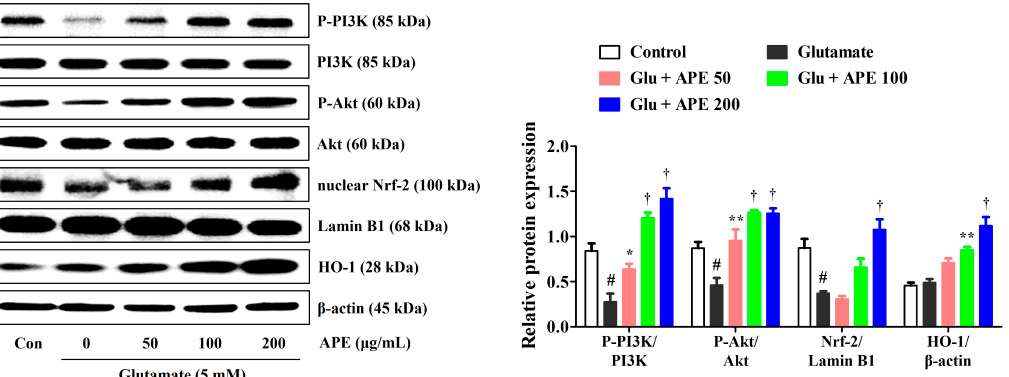
Figure 6. Effects of Arecae Pericarpium ethanol extract on the phosphorylation of PI3K and protein kinase B, the nuclear translocation of Nrf-2, and the expression of HO1 in glutamate-exposed HT22 cells. Cells were pretreated with APE at concentrations of 50, 100, or 200 µ g/mL and then treated with glutamate (5 mM). Control was non-treated cells. Blot images represent the three independent experiments. Data were presented as mean ± standard error of the mean. Statistical significance was set at # p < 0.05 (vs. control), * p < 0.05, ** p < 0.01, and † p < 0.001 (vs. glutamate). Akt, protein kinase B; APE, Arecae Pericarpium ethanol extract; Con, control; Glu, glutamate; HO1, heme oxygenase-1; Nrf-2, nuclear factor erythroid 2-related factor 2; PI3K, phosphoinositide